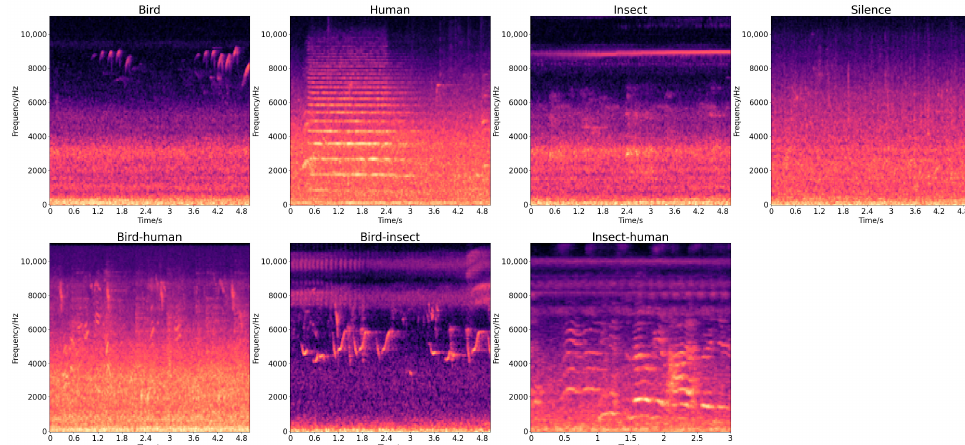
Figure 1. Mel spectrograms for different acoustic scenes.